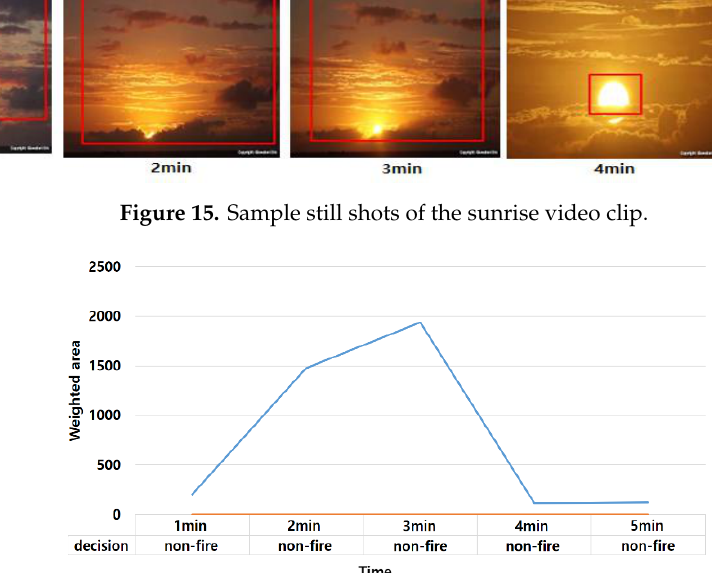
Figure 16. Changes in areas of flame and smoke with final decisions by majority voting for the video clip of Figure 15.